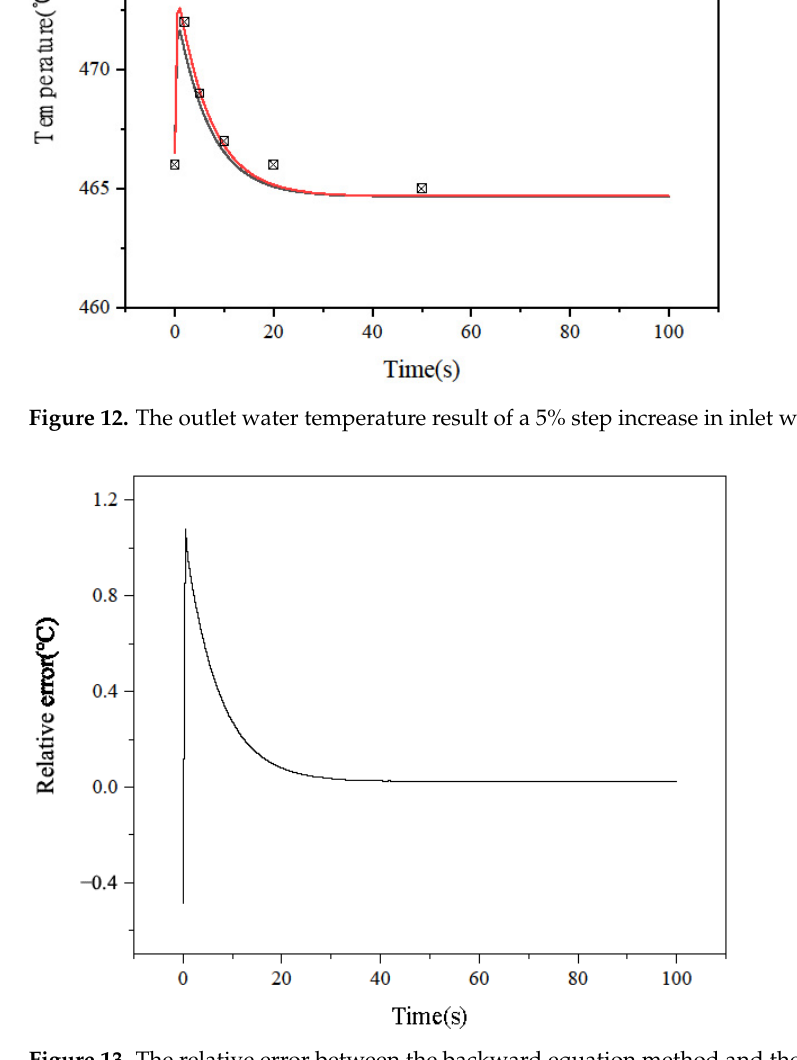
Figure 13. The relative error between the backward equation method and the original method of a 5% step increase in inlet water pressure.